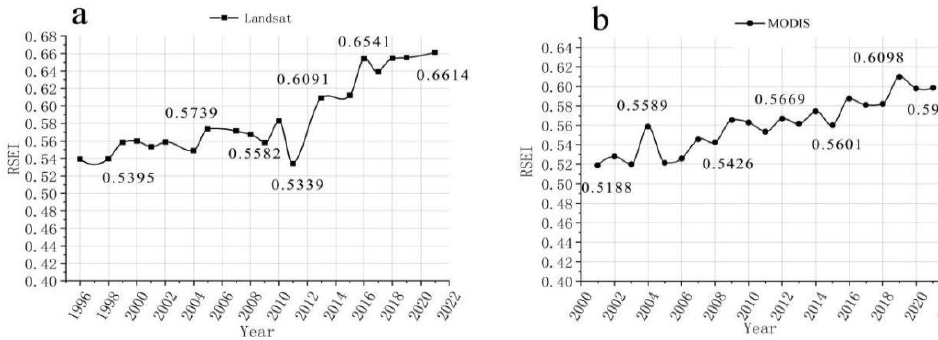
Figure 4. Trend in RSEI. ( a ) Trend in RSEI from Landsat, resolution of 30–60 m, higher precision, more ideal map results; ( b ) Trend in RSEI from MODIS, karst mountainous terrain broken, small plot area, not applicable, for reference only.